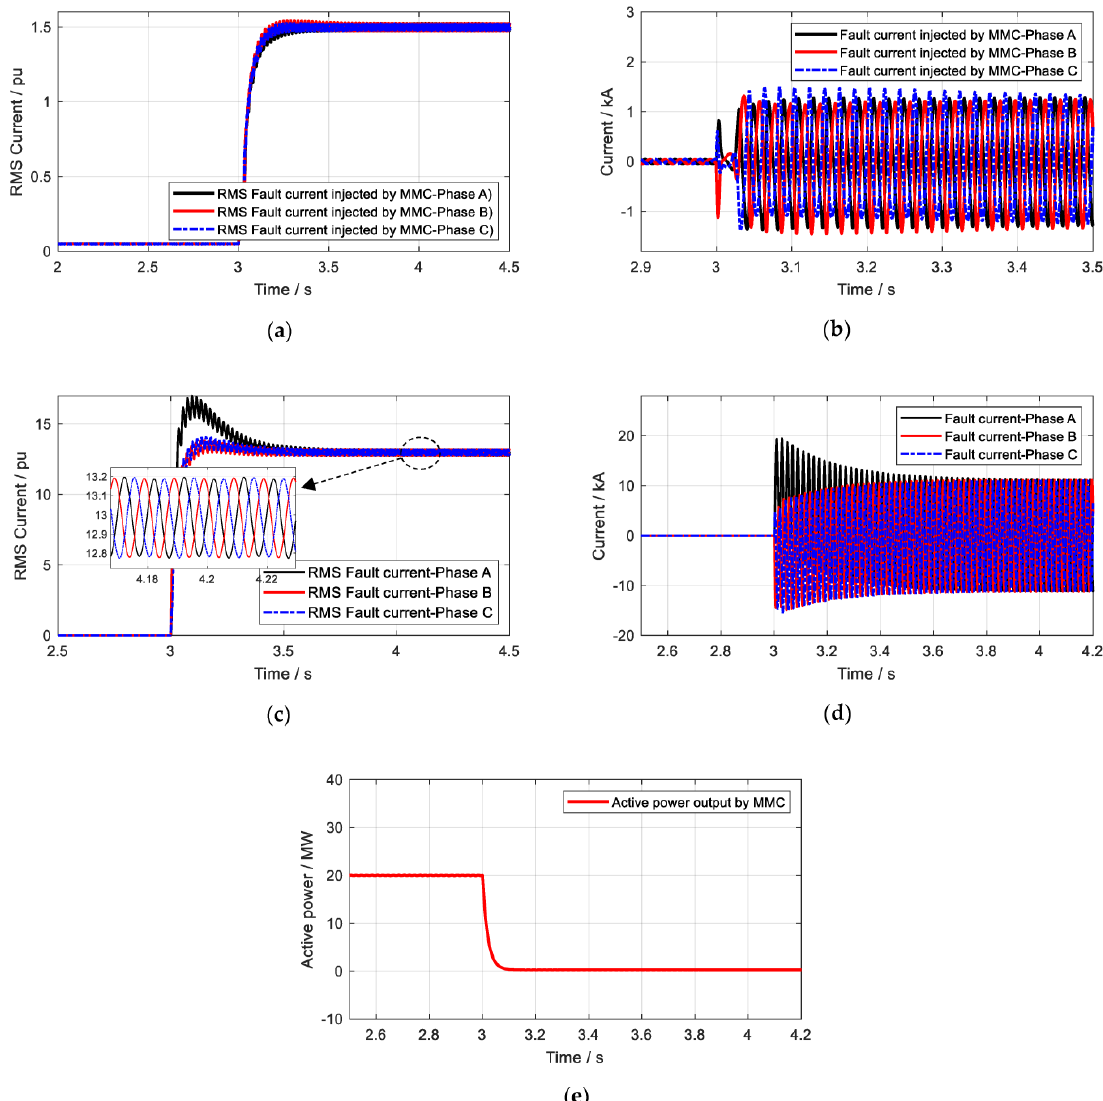
Figure 14. The simulation situations in case 4. ( a ) The RMS short-circuit current injected by the MMC after the fault. ( b ) The instantaneous short-circuit current injected by the MMC after the fault. ( c ) The RMS short-circuit current of the whole system after the fault. ( d ) The instantaneous short-circuit current of the whole system after the fault. ( e ) The active power transmitted by the MMC.